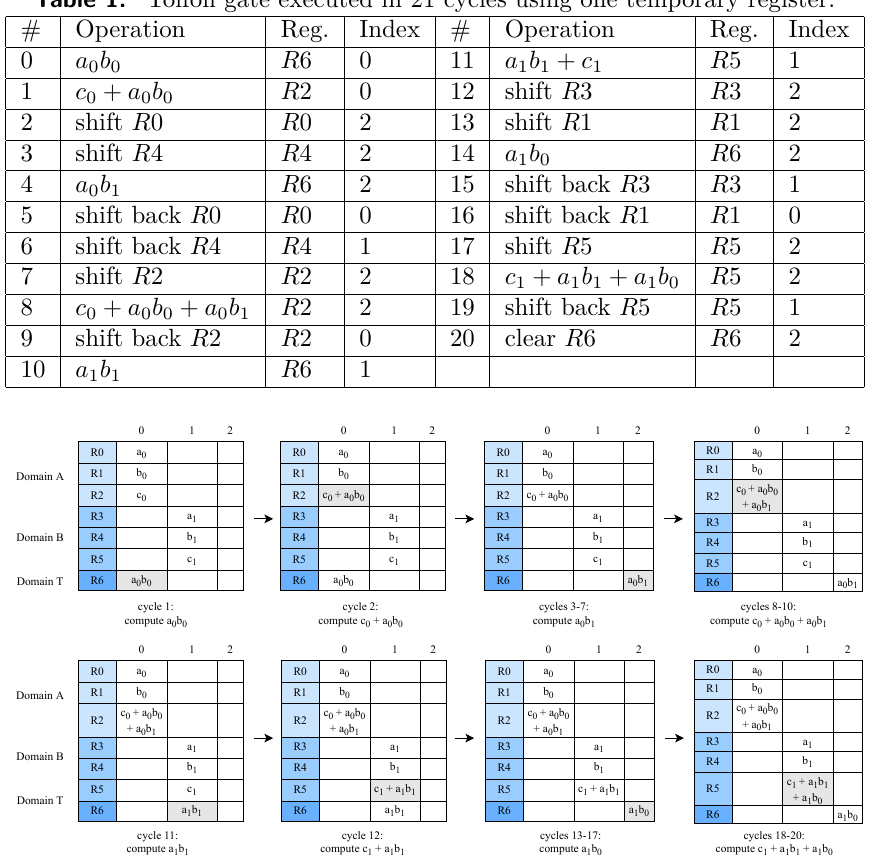
Figure 5: Outputs c 0 and c 1 of the Toffoli gate. In this masking, registers R0-R2 belong to domain A, R3-R5 belong to domain B, and R6 is a temporary register in domain